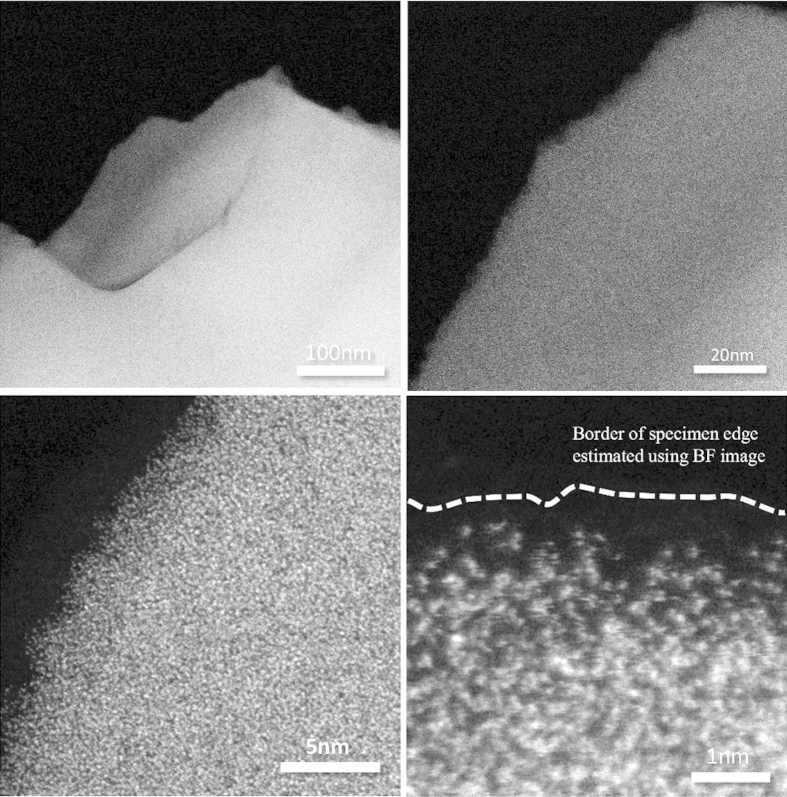
HAADF-STEM images at different magnifications for the 54Al2O3-46Ta2O5 glasses.